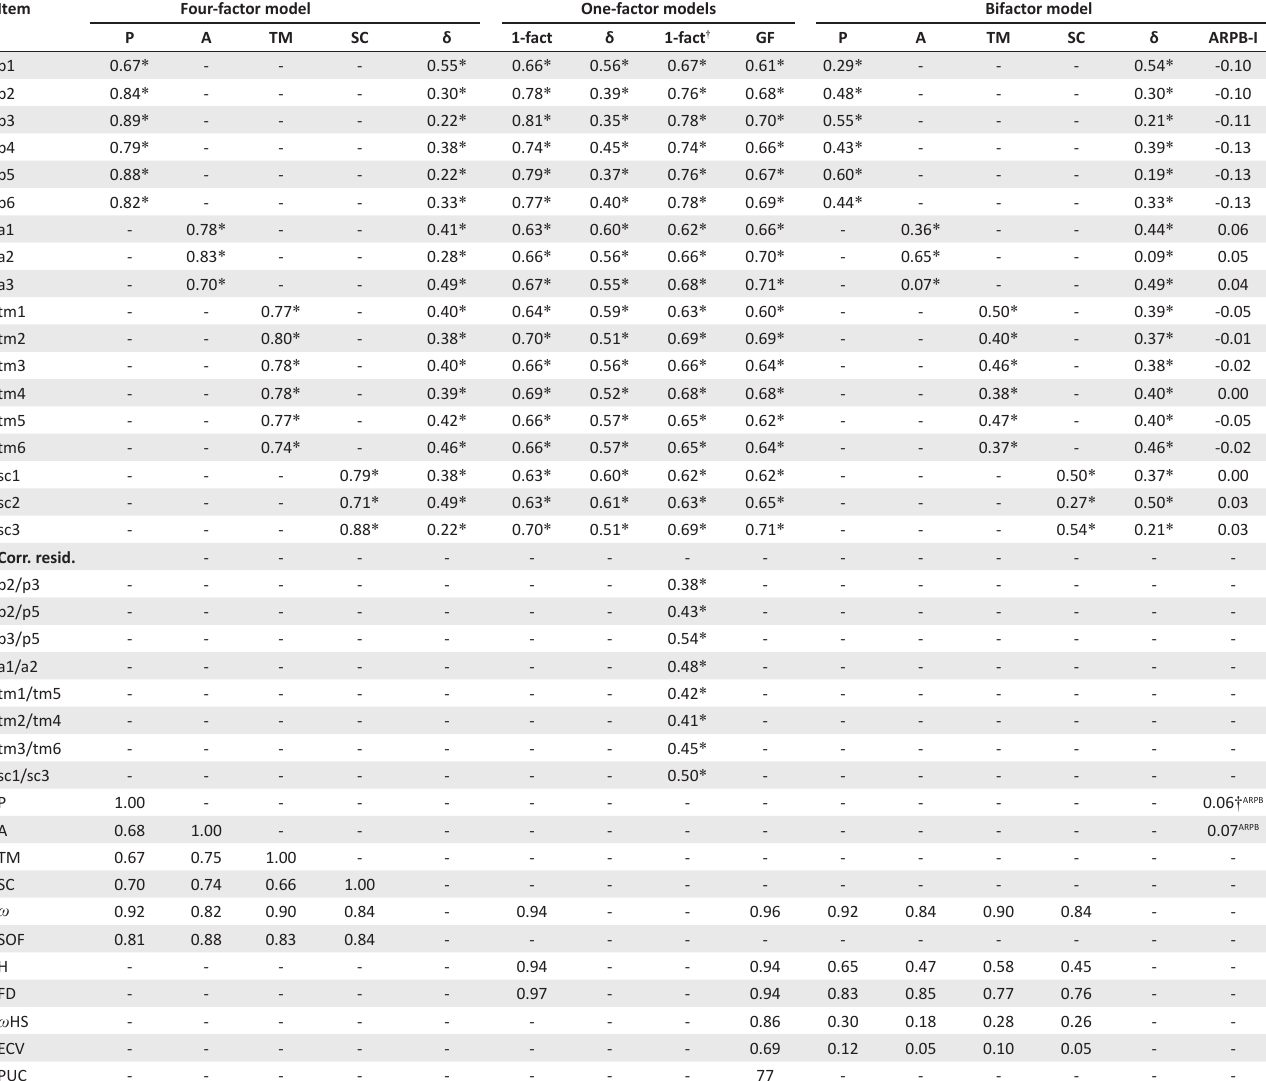
TABLE 2: Factor structure results of the confirmatory factor analysis analyses.